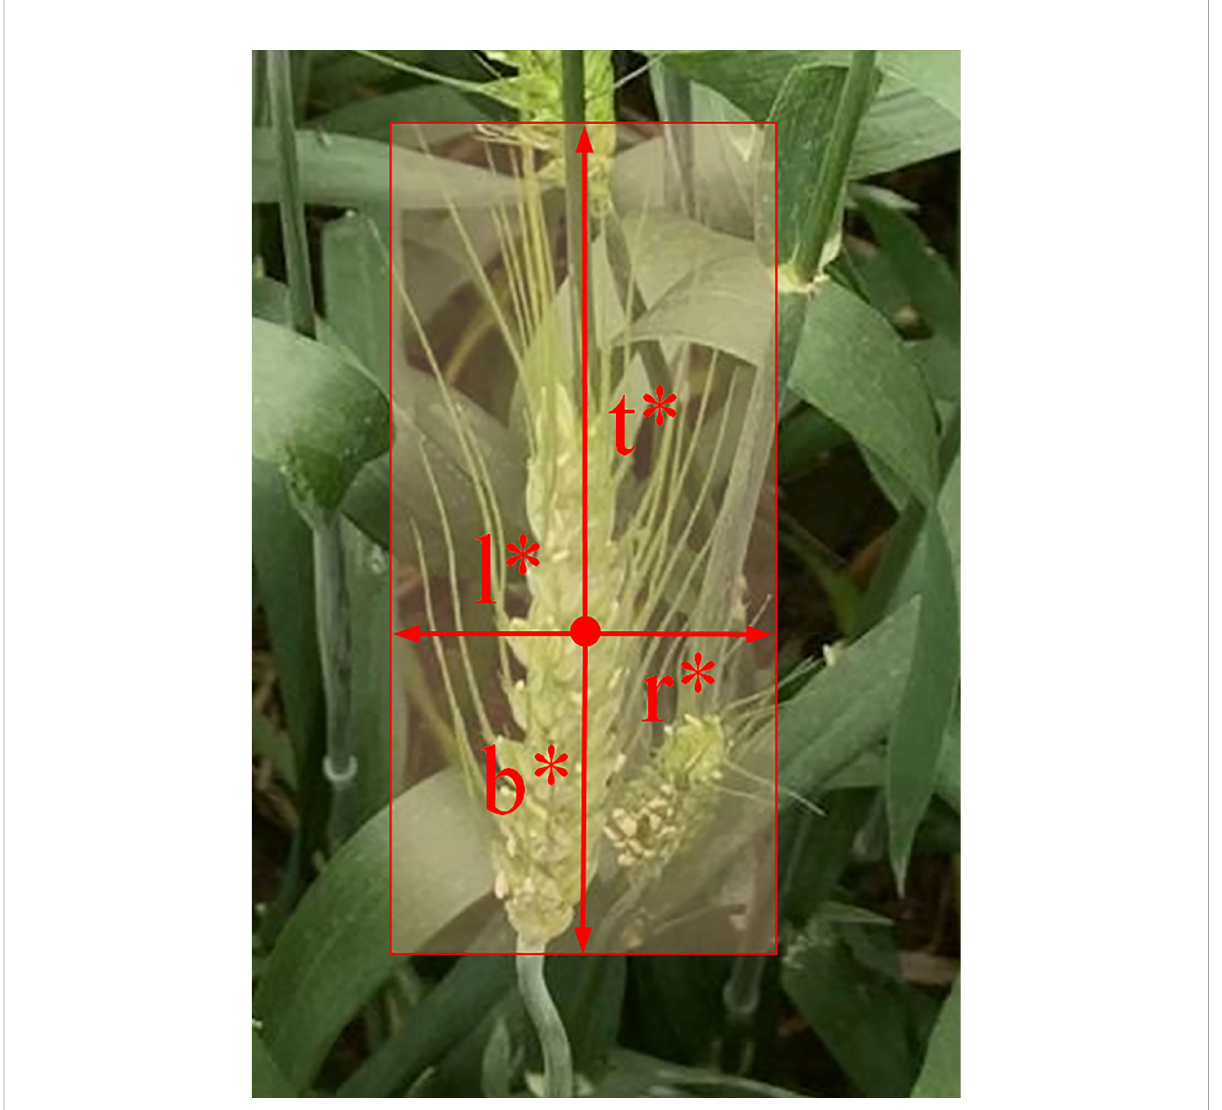
FIGURE 4 Regression method of FCOS. l *, t *, r *, and b * represent the distances from the pixel to the left, top, right, and bottom, respectively, of the bounding